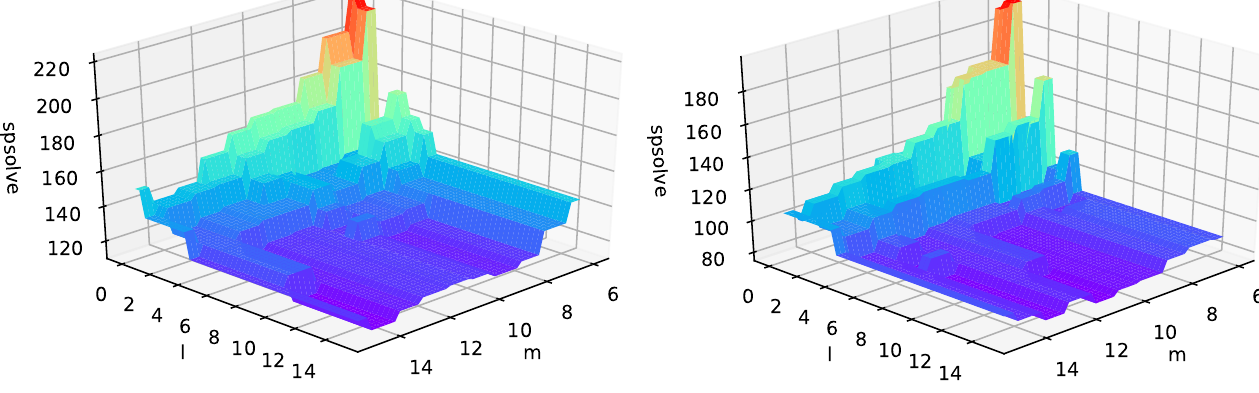
( b ) 3D profile of spsolve w.r.t. various m and l (D4, h = 0.1 ns) Figure 6. 3D